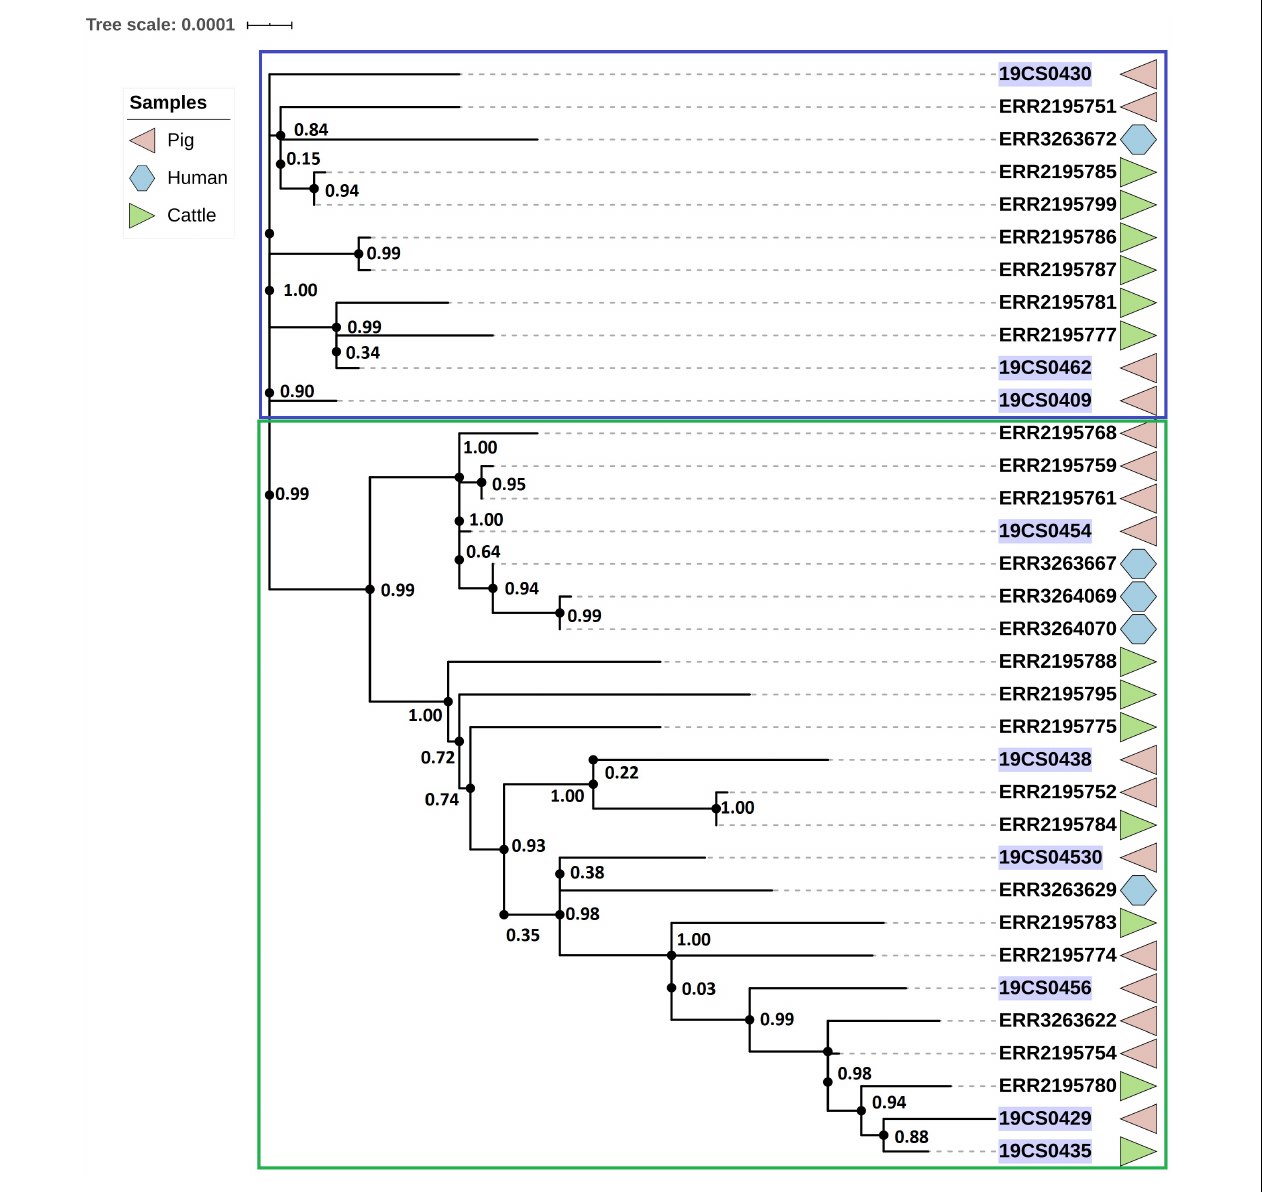
FIGURE 3 | Phylogenetic SNP-based tree of S. Derby ST39 strains. Clusters are labeled in colored rectangles: cluster 1 (blue) and cluster 2 (green). The colored figures alongside the tree represent the source of the isolates: pig (pink), human (blue), and cattle (green). FLI isolates marked in purple.